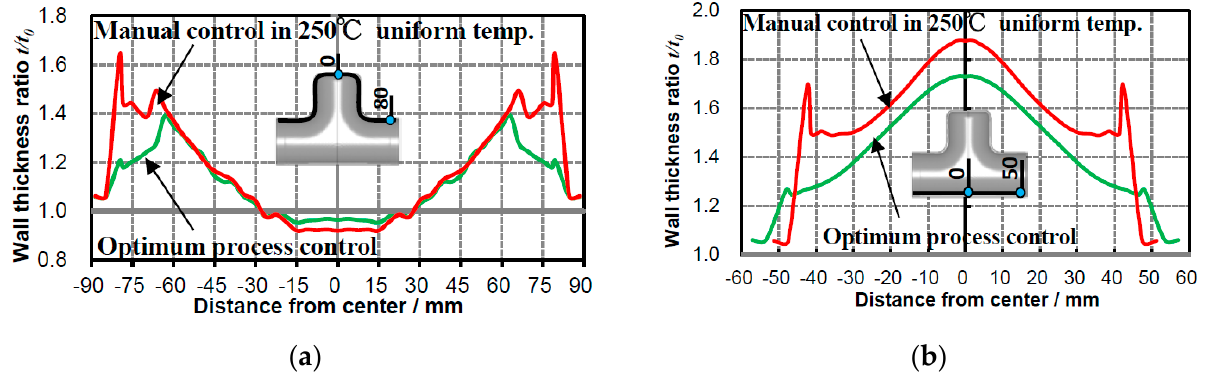
Figure 18. Comparison of wall thickness distribution between manual control and optimum process control (FE analysis).